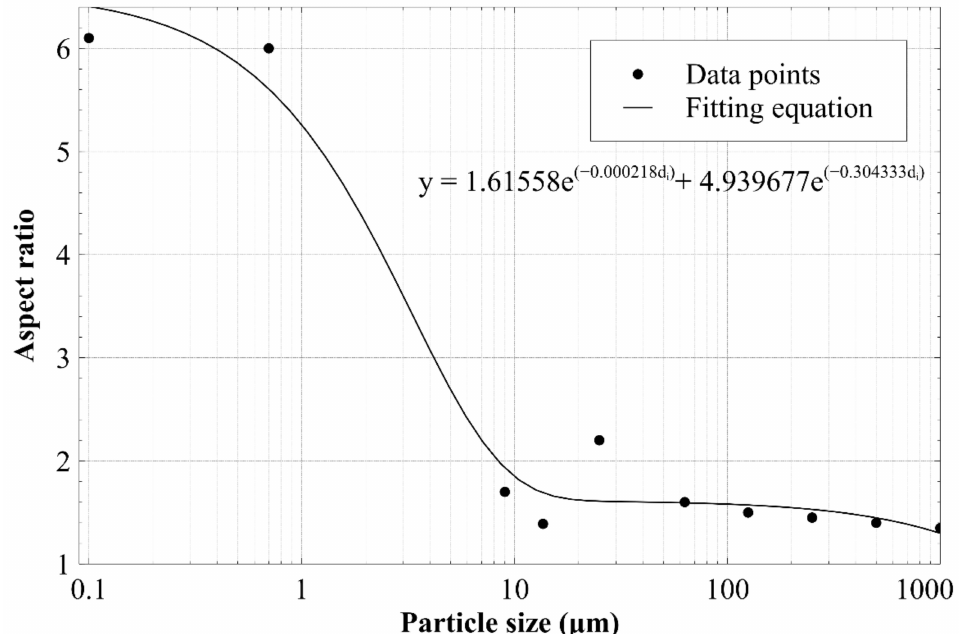
Figure 5. Collated values of the average aspect ratio found for different particle sizes from the literature, measured using optical, electron, or atomic microscopy. A fitting equation and function (solid line) is shown, which describes the general trend in the aspect ratio values observed, as a function of particle size diameter d i . Data adapted from